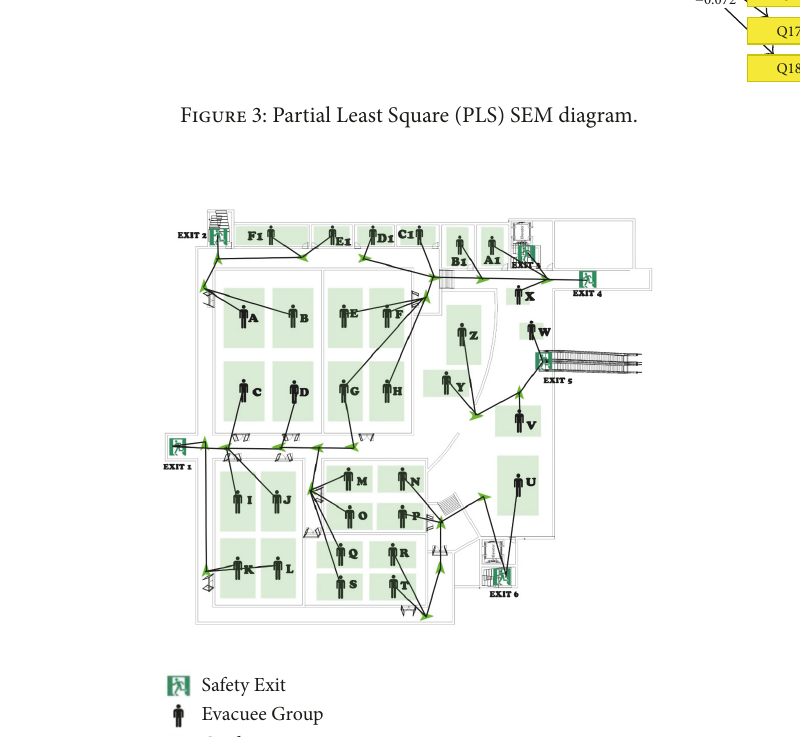
Figure 4: Visualization of routing solutions using “Bee-Fire”